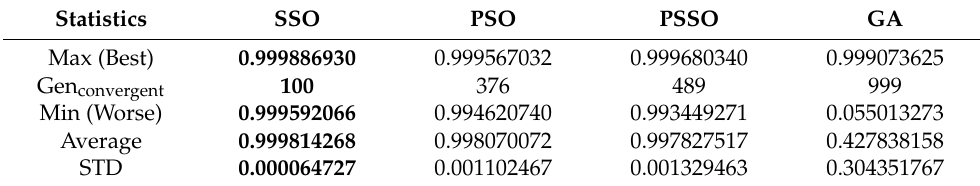
Table 8. The statistics of system reliability for benchmark 3.